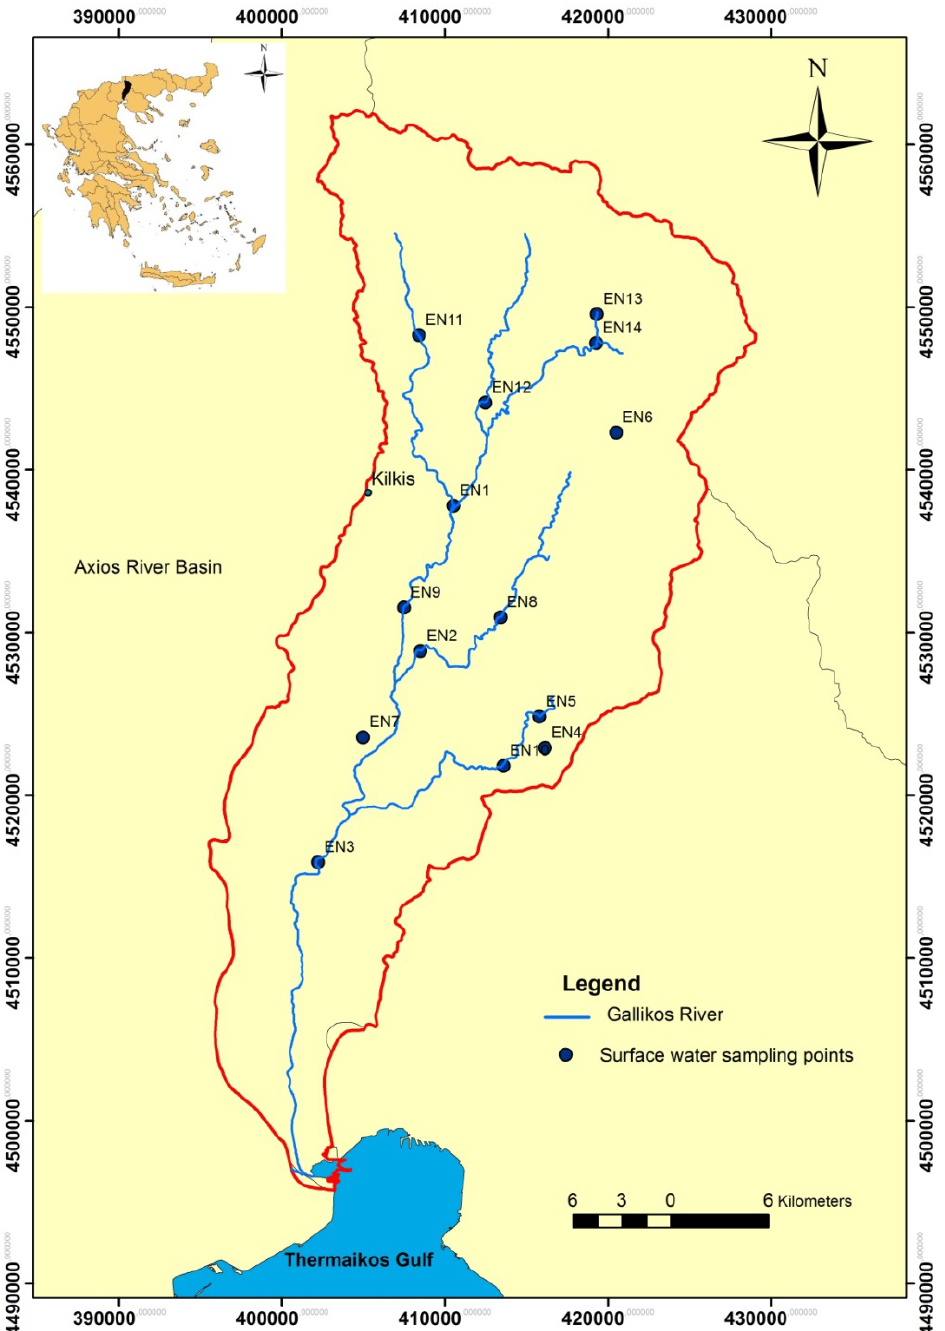
Figure 5. Surface water sampling